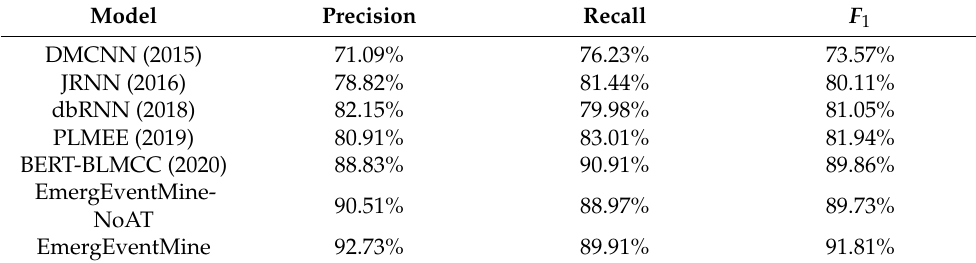
Table 4. Overall